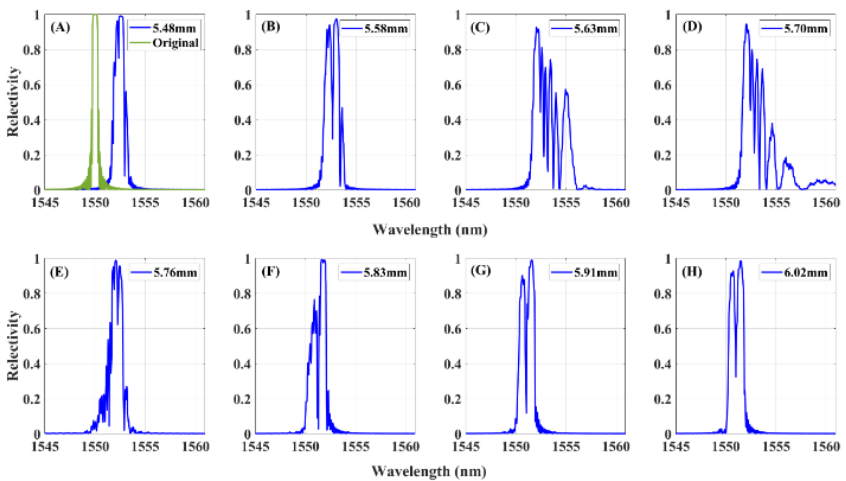
Figure 6. Experimental reflection spectra of FBG1 sensor for different crack lengths. ( A ) 5.48 mm; ( B ) 5.58 mm; ( C ) 5.63 mm; ( D ) 5.70 mm; ( E ) 5.76 mm; ( F ) 5.83 mm; ( G ) 5.91 mm; ( H ) 6.02 mm.